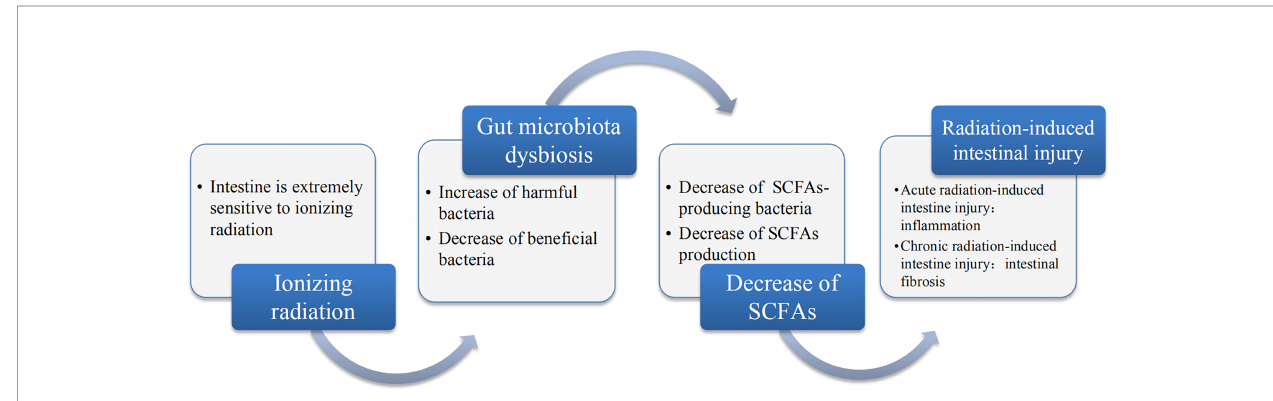
FIGURE 2 | The relationship between ionizing radiation, gut microbiota, SCFAs and radiation-induced intestinal injury. Ionizing radiation can lead to dysbiosis of gut microbiota, which is mainly disruption and it leads to the decrease of bene fi cial bacteria and increase in harmful or pathogenic bacteria. Gut microbiota dysbiosis includes the decrease in SCFAs-producing bacteria, which may result in the decrease of SCFAs. The decrease of SCFAs may be a major pathogenesis of radiation- induced intestinal